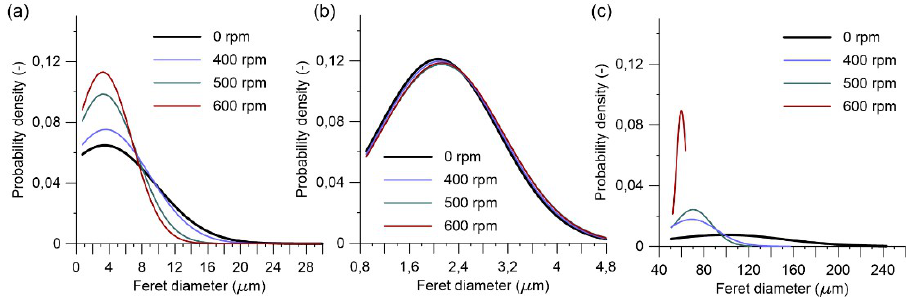
Figure 11. Particle size distribution of a Swedish raw clay at different grinding speeds for diameter ranges: ( a ) entire range; ( b ) clay particle size range; ( c ) agglomerates over 50 μ m range.